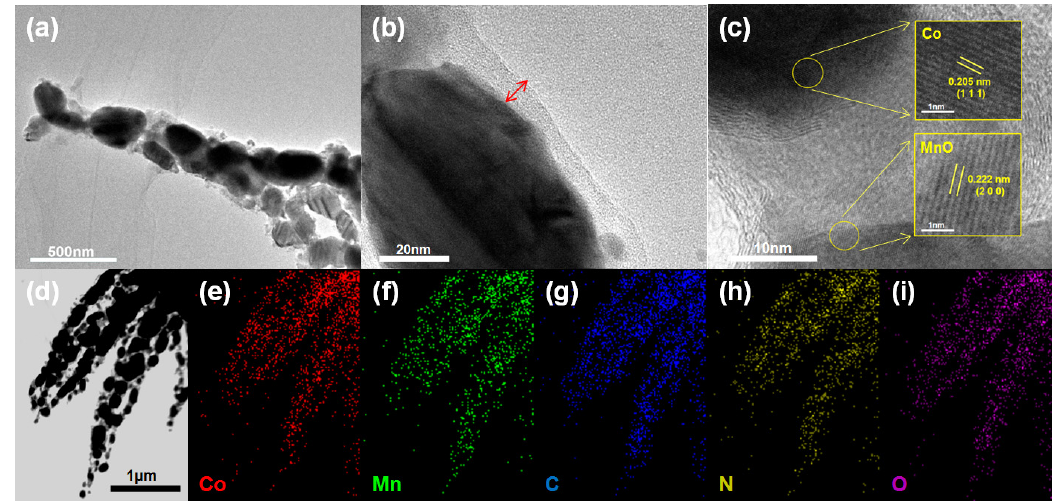
Figure 3. ( a and b ) TEM images of S-600, ( c ) HR-TEM image, and ( d-i ) Elemental maps of S-